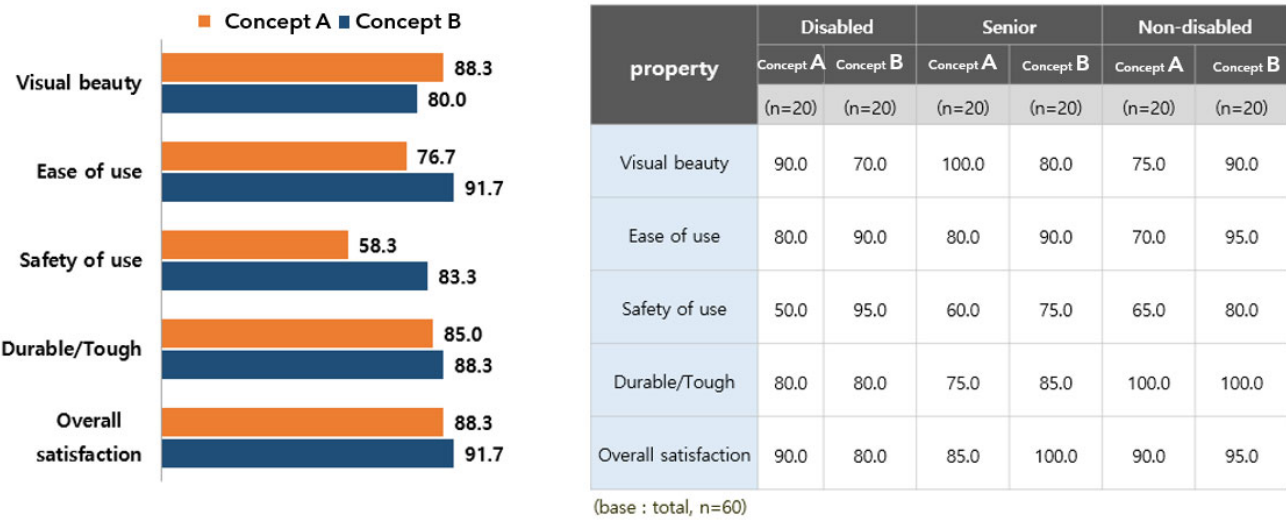
Figure 11. The result of attribute evaluation of the treadmill product design.